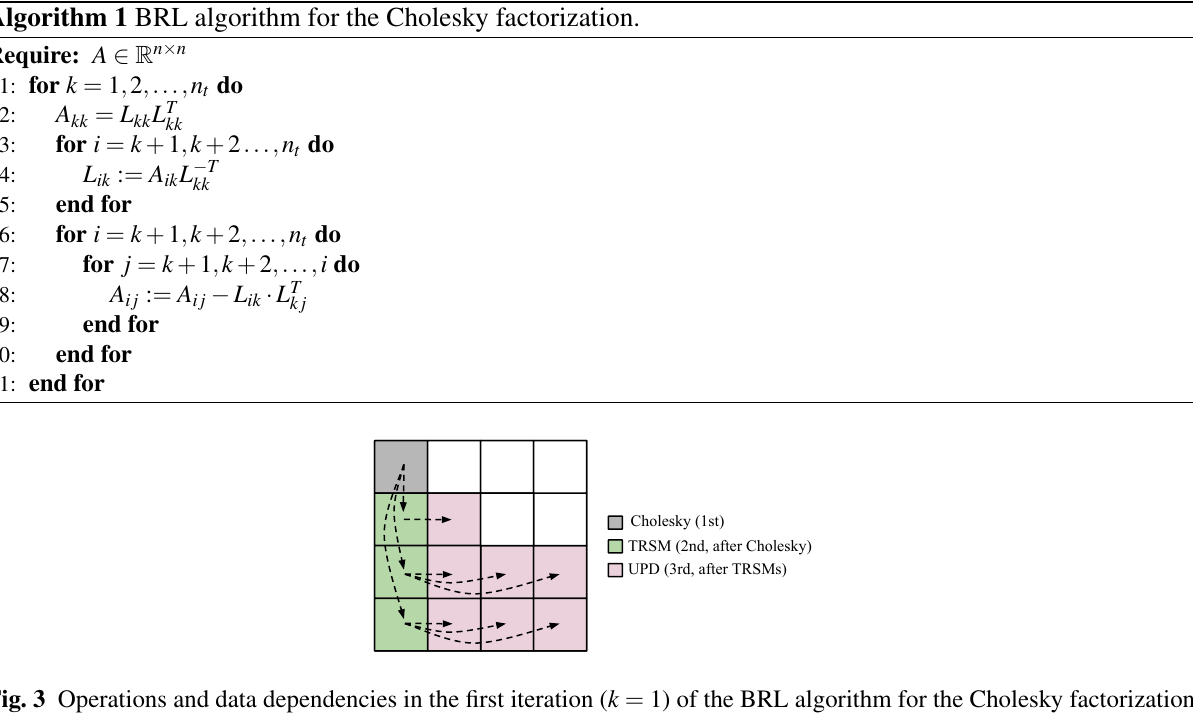
Algorithm 1 BRL algorithm for the Cholesky factorization.